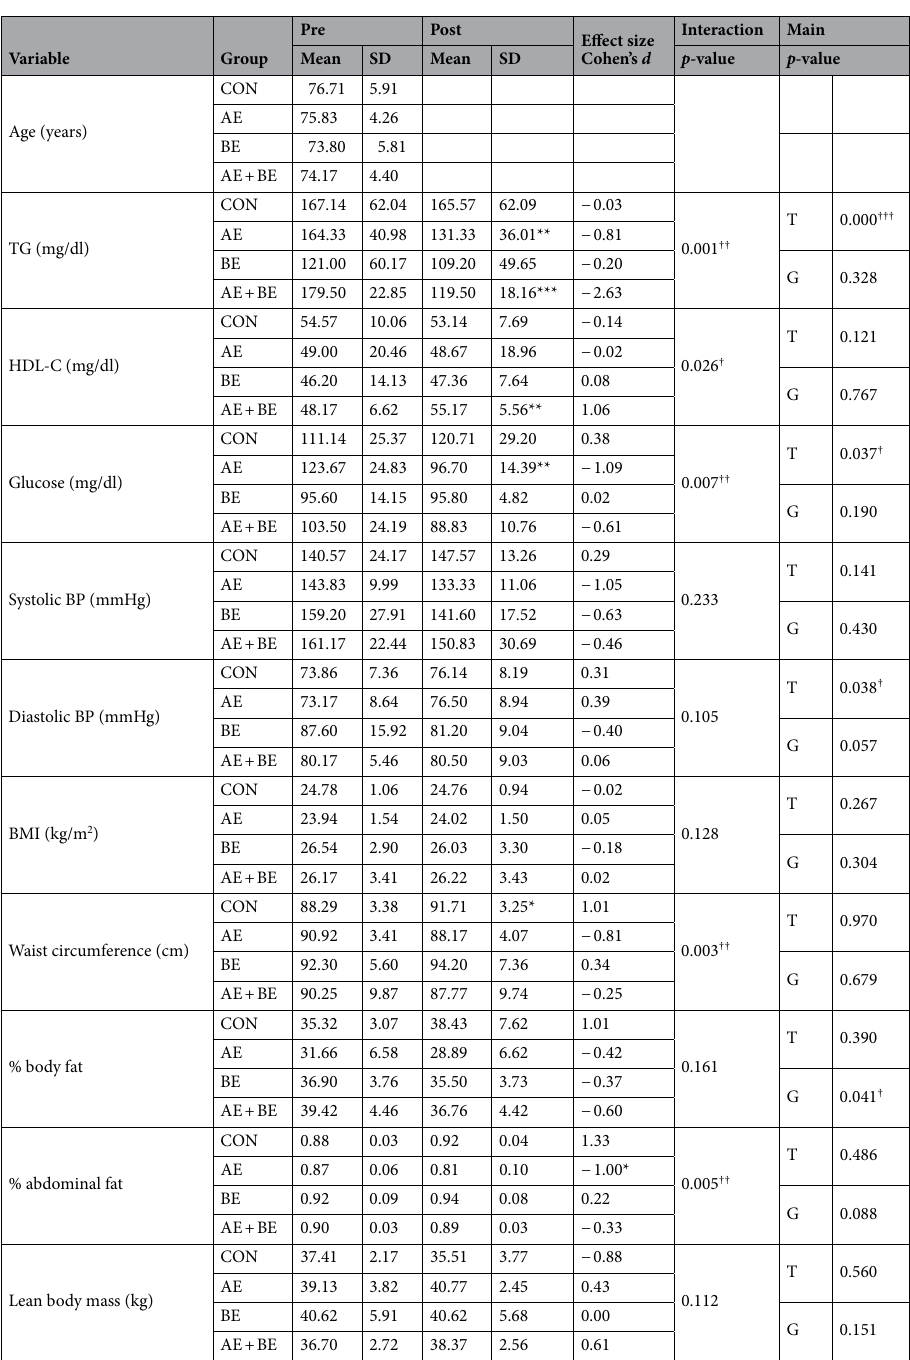
Table 1. Effects of a 16-week aquatic exercise (AE) and burdock root extract (BE) intervention on metabolic syndrome and body composition parameters. Repeated measures ANOVA (time × group) showed a main effect and interaction on all parameters. CON control, BMI body mass index, TG triglycerides, HDL- C high density lipoprotein cholesterol, BP blood pressure, T time effect, G group effect. Values are